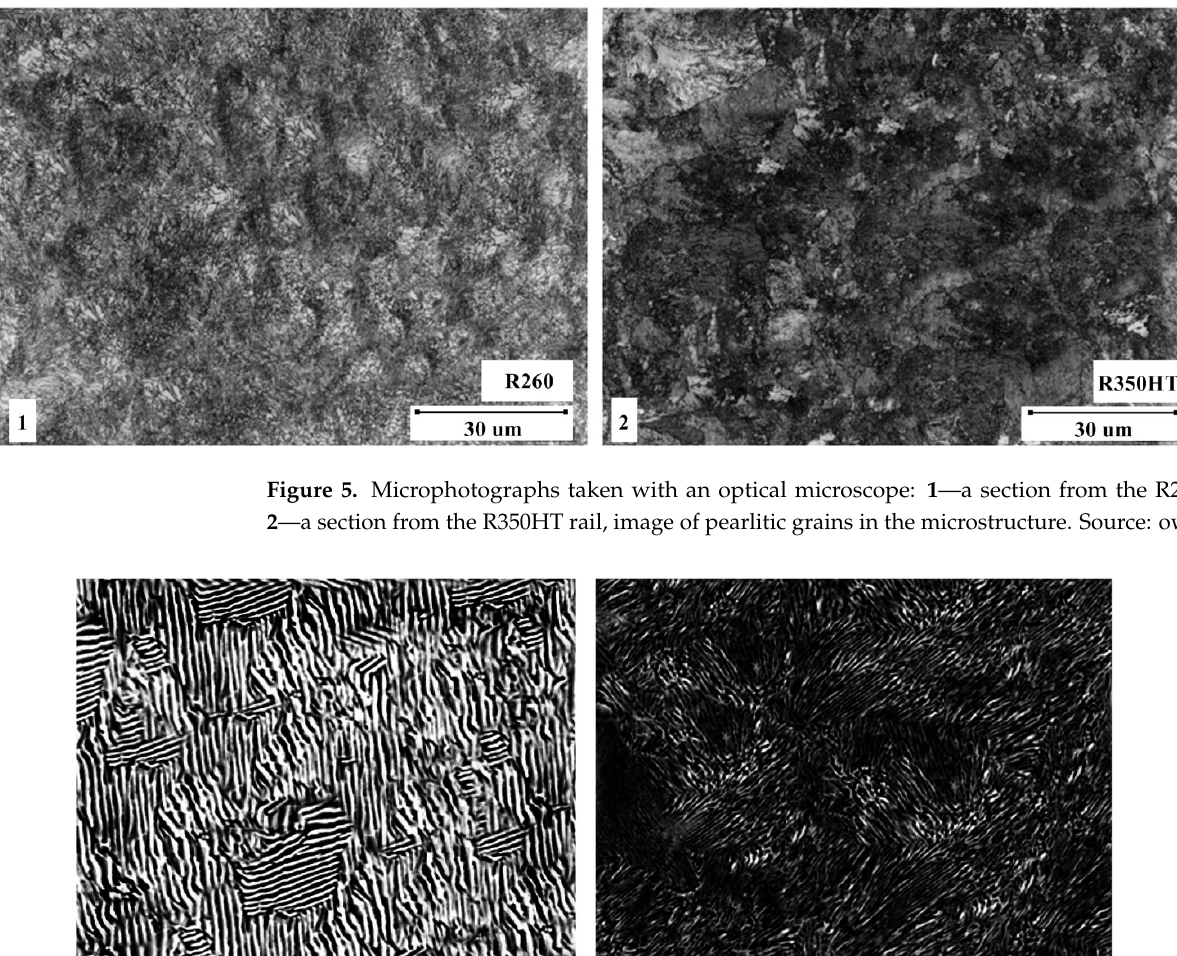
Figure 4. Welding method of rail joints: butt positioning of rail ends in the welder. Source: own.